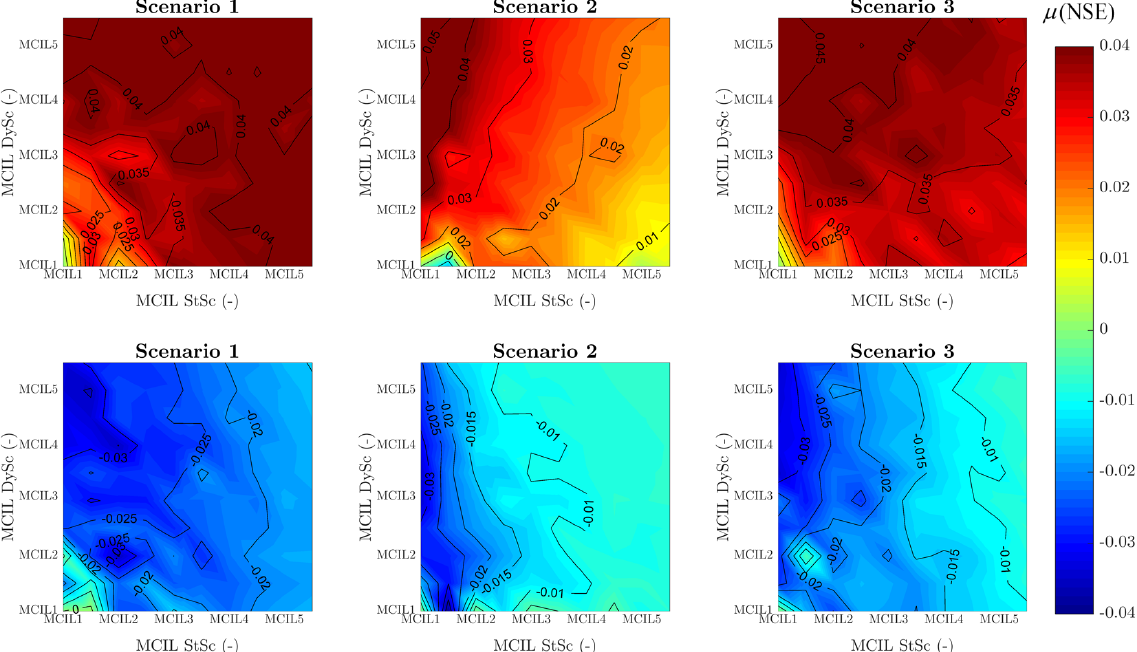
Figure 10. Difference between µ ( NSE ) values obtained considering bias 2 with bias 3 (first row) and bias 2 with bias 4 (second row) for different involvement levels for StSc and DySc